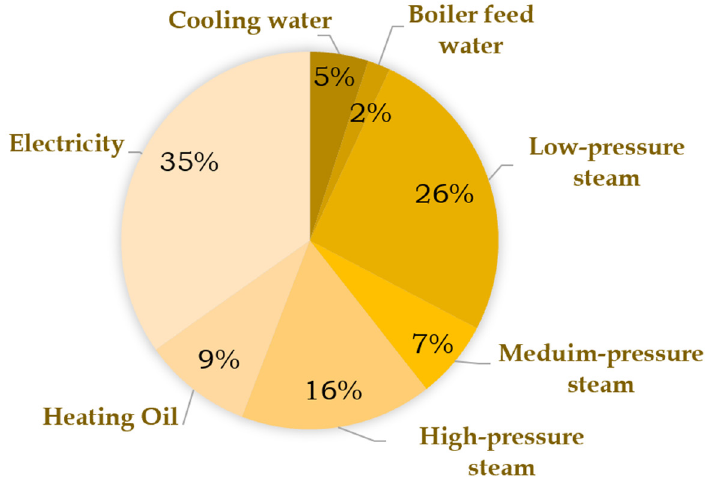
Figure 6. Utility cost distribution for the MIBK